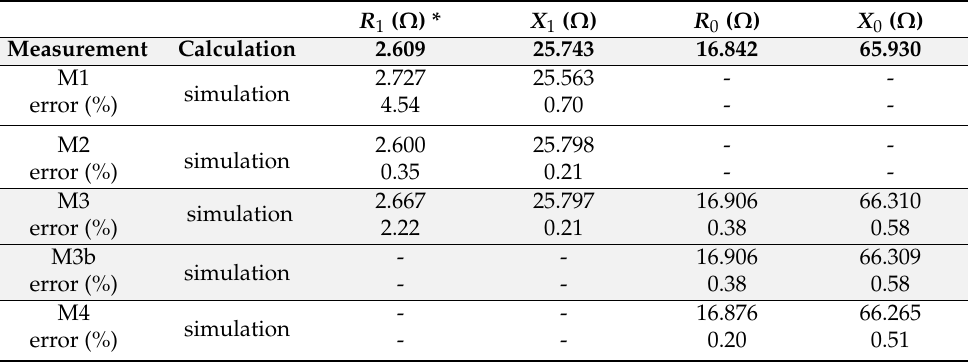
Table 5. Comparison of simulation results of investigated power line.